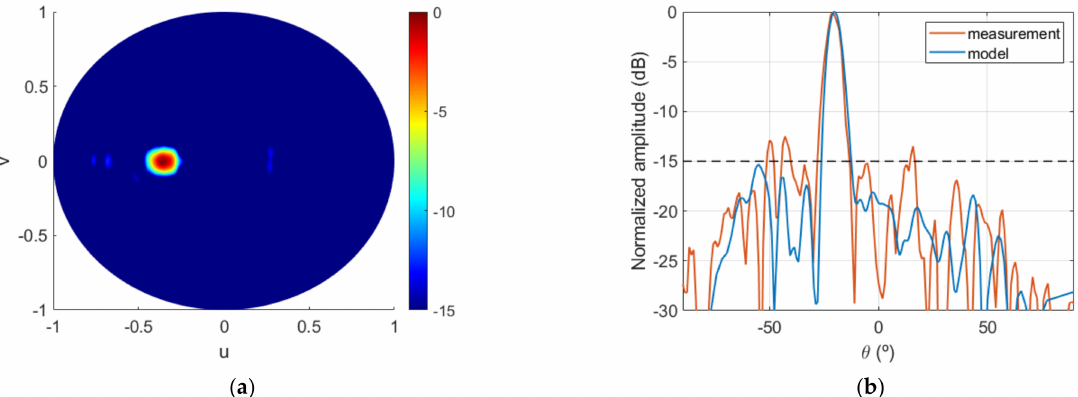
Figure 12. Case 1, FF results of the prototype: ( a ) measured radiation pattern (normalized amplitude, dB); ( b ) comparison of model result and measurement for cut v = 0.